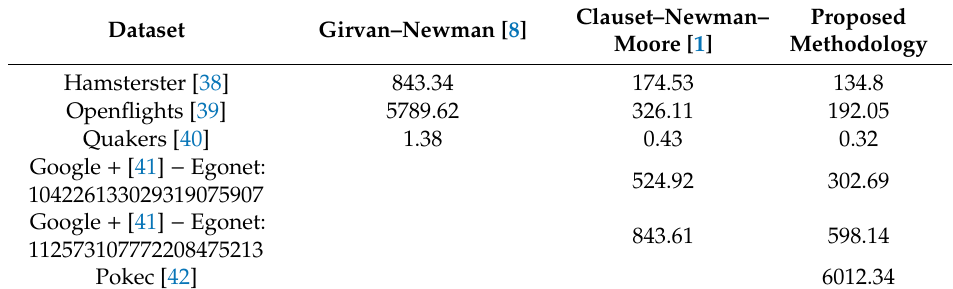
Table 3. The average required execution time (in seconds) per dataset and community detection method applied after 20 executions.